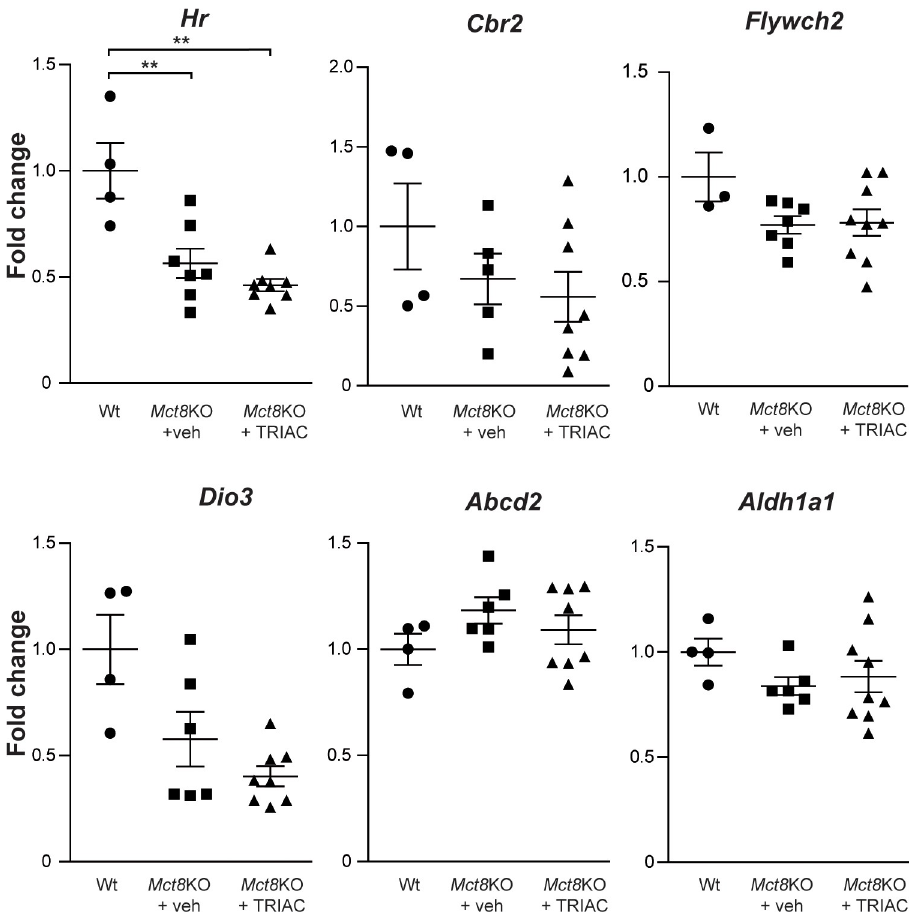
Fig 4. Gene expression analysis of T3-regulated genes in the cerebral cortex of vehicle treated Wt ( Hr n = 4; Cbr2 n = 4; Flywch2 n = 3; Dio3 n = 4; Abcd2 n = 4 and Aldh1a1 n = 4 ), and Mct8 KO mice ( Mct8 KO+veh; Hr n = 7; Cbr2 n = 5; Flywch2 n = 7; Dio3 n = 6; Abcd2 n = 6 and Aldh1a1 n = 6) and in Mct8 KO mice after TRIAC treatment ( Mct8 KO+TRIAC; Hr n = 8; Cbr2 n = 8; Flywch2 n = 9; Dio3 n = 8; Abcd2 n = 8 and Aldh1a1 n = 9). Measurements were obtained by qPCR, and results were corrected for 18S RNA content. Data are expressed as scatter plots and mean ± SEM and �� p < 0.01 was determined by one-way ANOVA and Bonferroni’s post hoc test. Hr , hairless mRNA; Cbr2 , carbonyl reductase mRNA; Flywch2 , FLYWCH family member 2 mRNA; Dio3 , type 3 iodothyronine deiodinase mRNA; Abcd2 , ATP-binding cassette, sub-family D (ALD), member 2 mRNA and Aldh1a1 , aldehyde dehydrogenase family 1, subfamily A1